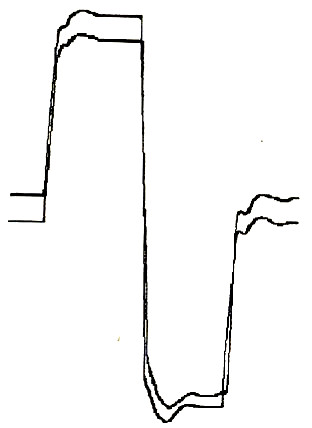
A biphasic waveform adopted for ECT. A diagram showing the electrical features of a biphasic electric pulse generated by a CHEMOPULSE.